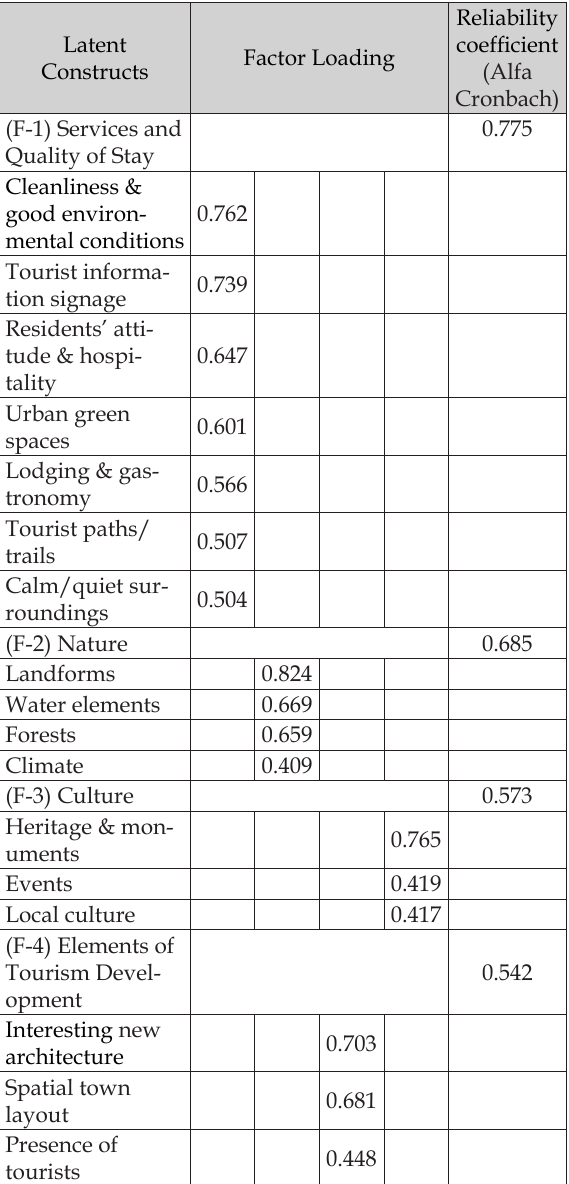
Table 5. Results of Principal Factor